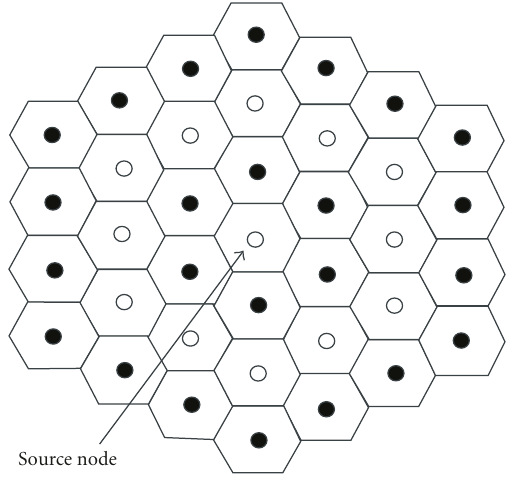
Figure 3: Wireless Mesh Backhaul